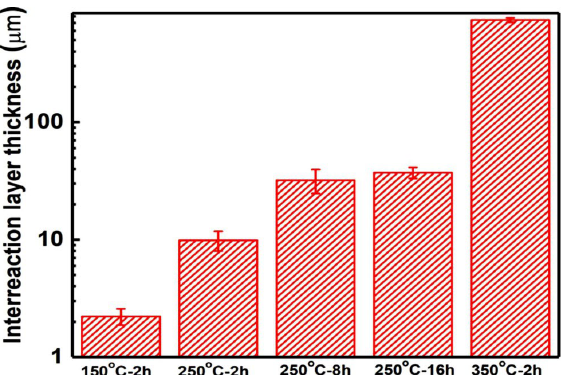
Figure 3. Thickness of inter-diffusion layers in Zn coatings after different heating conditions.